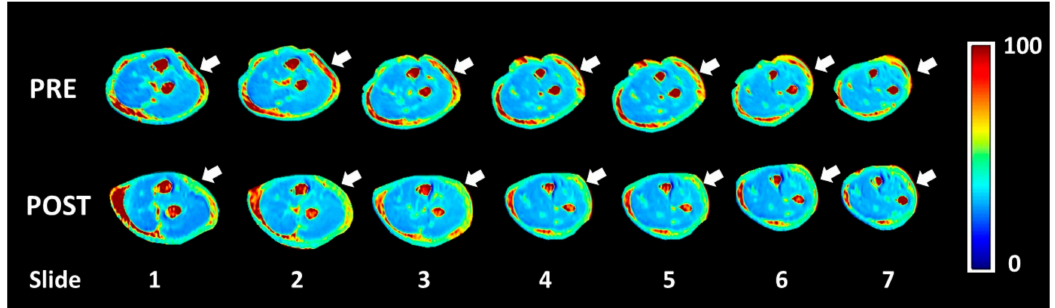
Figure 5. Pre- and post-T 1 (cid:37) -mapping of brachial fascia (in ms). The white arrows show the areas that were considered the most symptomatic from the patient. It can be seen a change of the color from red (unbound water) in the pre-treatment imaging to green-blue (bound water that works as a lubricant) in the post-treatment